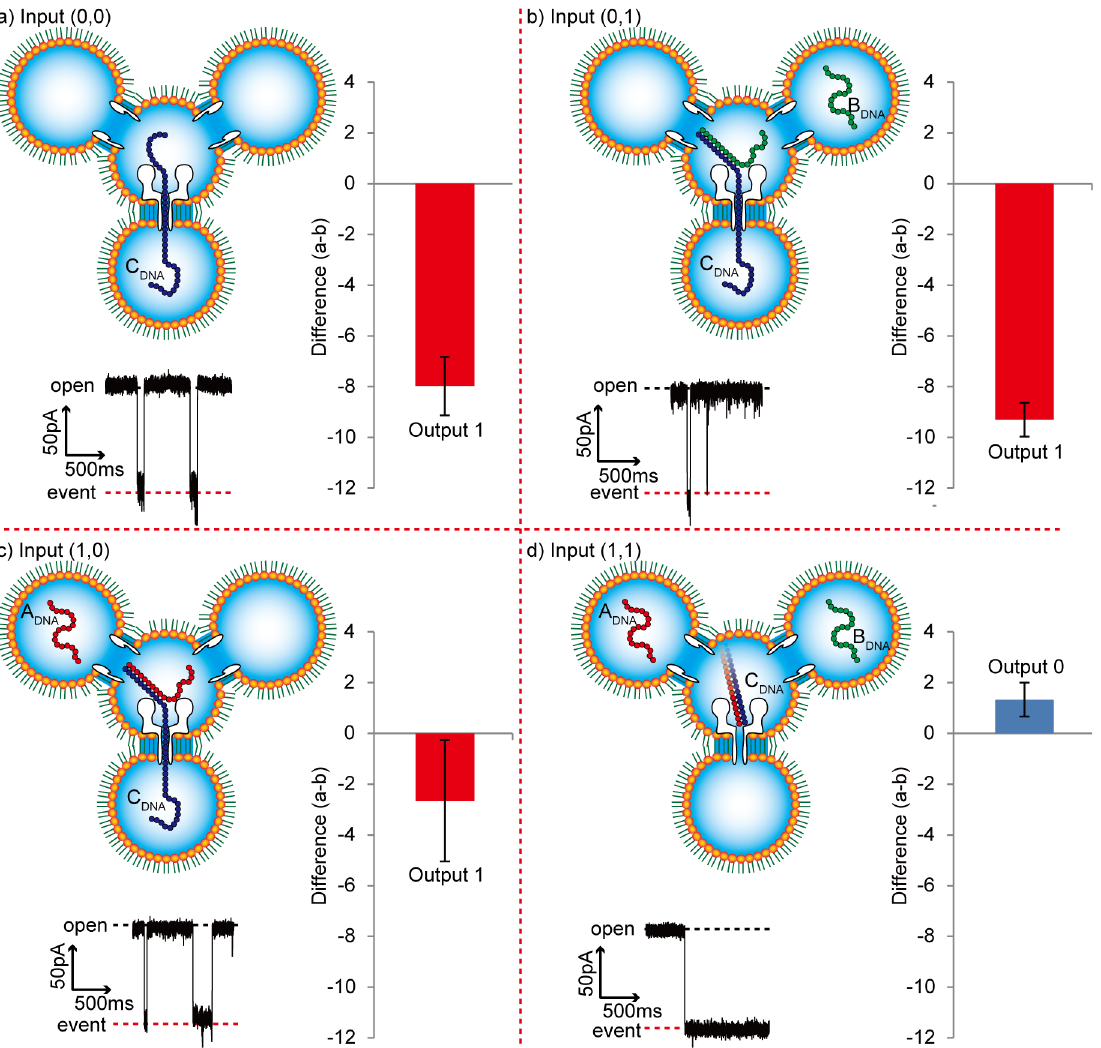
Fig 5. Outputs of the Negative-AND operation in a four-droplet network. The operation was performed as follows: Collect 10 DNA translocation or blocking events for a single calculation. Measure duration of each blocking event. Differentiate the events into two groups, those greater than 1 s (number of events = a) and those not greater than 1 s (number of events = b). Calculate a – b, and determine the output as: Output 1: a – b < 0 or Output 0: a – b > 0. Standard errors were determined using the output from three operations. (a) input (0, 0): a – b = – 8.0 ± 1.2, output = 1. (b) input (0, 1): a – b = – 9.3 ± 0.7, output = 1. (c) input (1, 0): a – b = – 2.7 ± 2.4, output = 1. (d) input (1, 1): a – b = 1.3 ± 0.7, output =